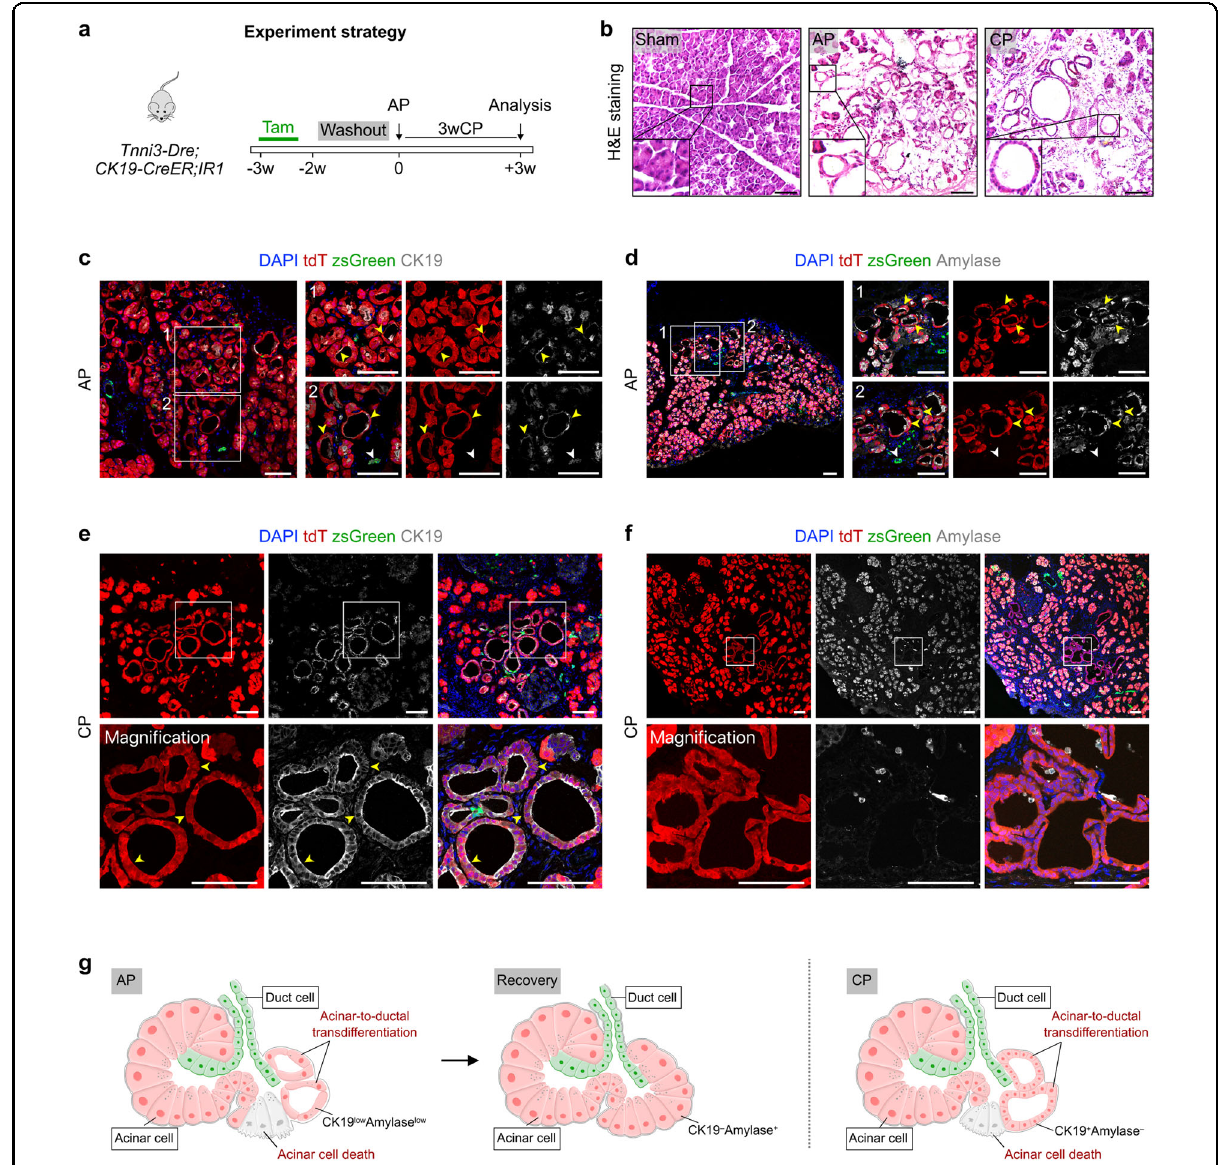
Fig. 6 Acinar-to-ductal transdifferentiation occurs during caerulein-induced pancreatitis. a Schematic diagram illustrating the experimental strategy for Tam treatment, caerulein-induced AP and CP. b H&E staining of pancreatic sections from the indicated mice. c – f Immunostaining of tdT, zsGreen and CK19 ( c , e ) or Amylase ( d , f ) on pancreatic sections collected from the indicated mice. White arrowheads, zsGreen + ductal cells. Yellow arrowheads, tdT + ductal cells. g Diagram illustrating that a subset of ductal cells is derived from tdT + acinar cells during the caerulein-induced pancreatitis. Scale bars, 100 μ m. Each image is representative of 5 individual